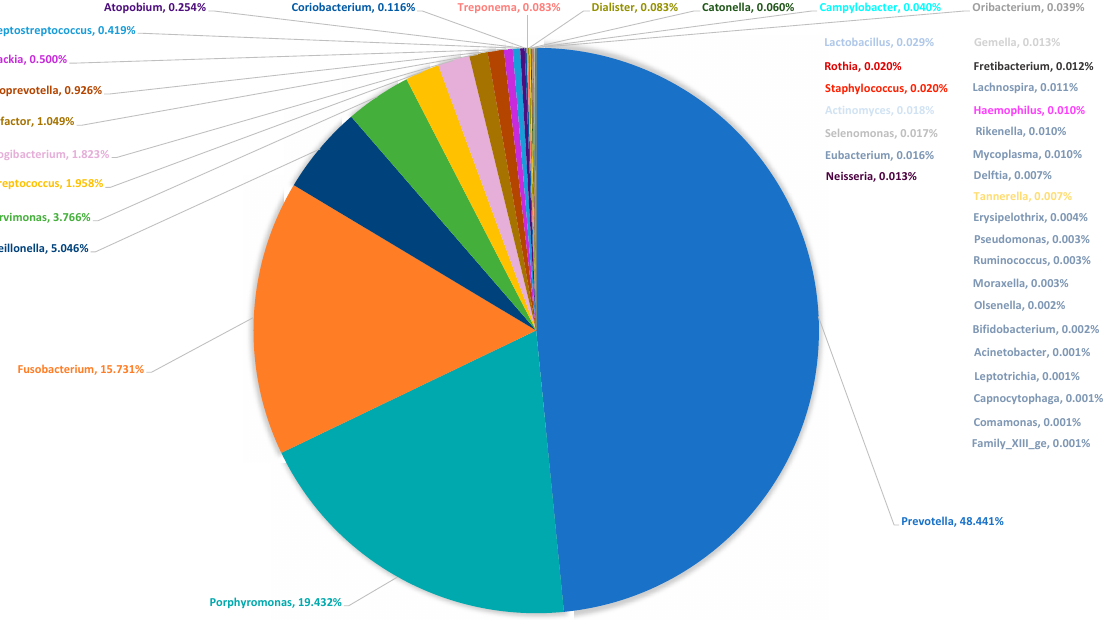
Figure 2. Culture results: The figure shows the absolute and relative frequency of the specifications given by the microbiological lab.